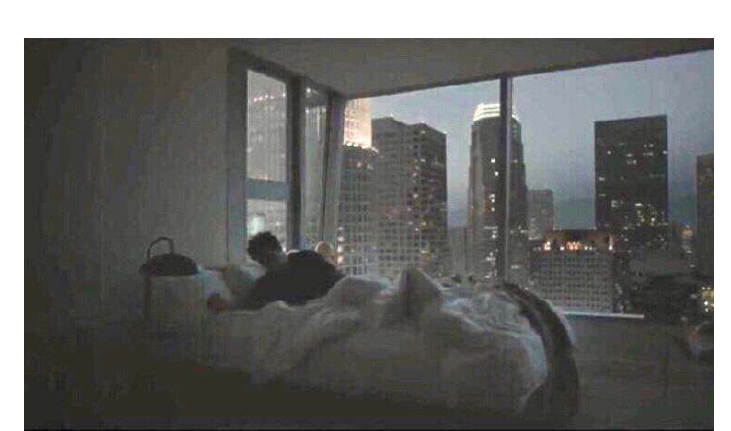
Figure 5. Theodore woke up from a